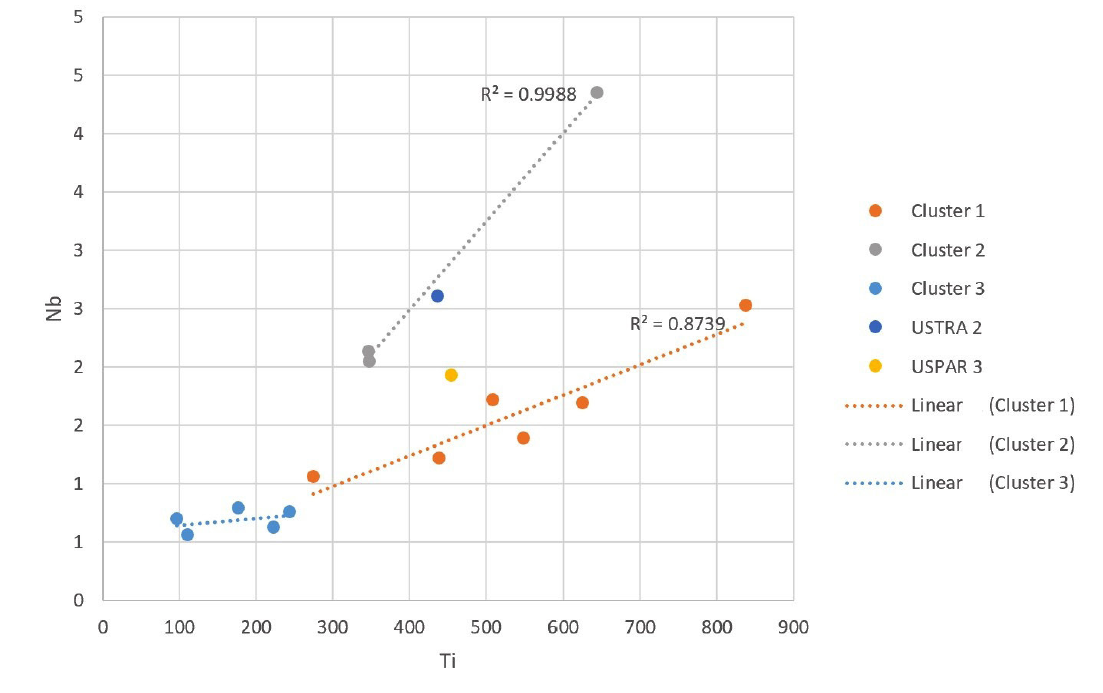
Figure 10: Correlations of titanium and niobium in three